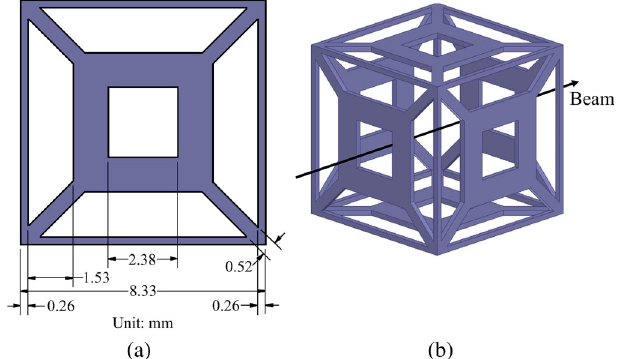
FIG. 1. Unit cell design geometry. (a) Face view. The thickness of each face is 0.26 mm. (b) 3D view. In later sections, we will introduce the electron beam that goes through the center of the beam holes of the cells lying on the beam line.